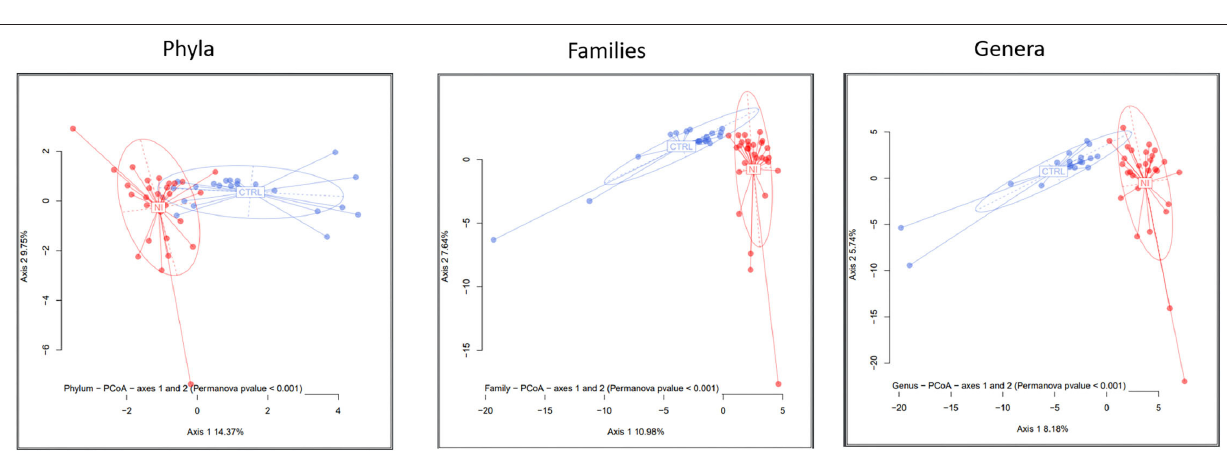
FIGURE 2 | A β -diversity analysis. The microbiota distances were visualized through Principal Coordinates Analysis (PCoA). The figure shows the taxonomic levels of phyla, families, and genera. The significance threshold ( p -value) for the PERMANOVA was set < 0.001. NI, children suffering from a neurological impairment, subjected to long-term enteral nutrition; CTRL, controls matched for sex and